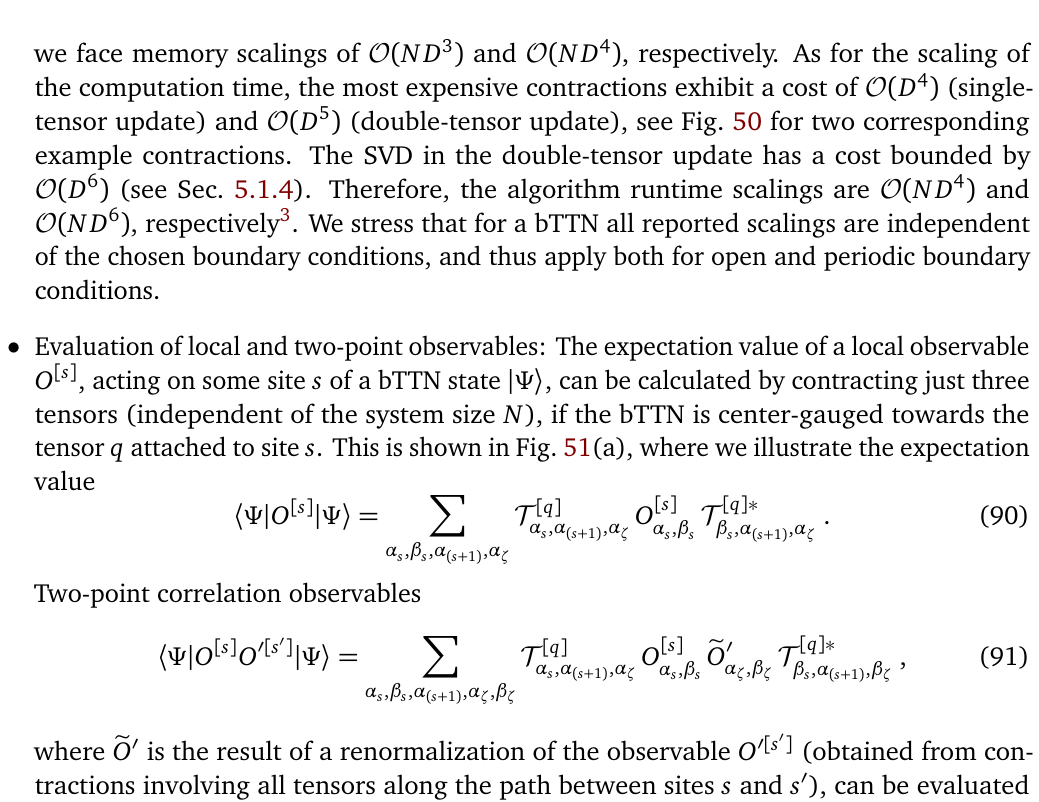
Figure 50: Examples for computationally most expensive contractions in a bTTN GS algorithm (as occurring during the application of the effective Hamiltonian, cf. Fig. 37(c)) in the case of (a) a single-tensor update scheme (contraction cost: O ( D 4 ) ), and (b) a double-tensor update scheme (contraction cost: O ( D 5 )